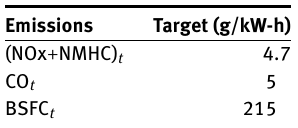
Table 5: Targets used for NOx, NMHC, and